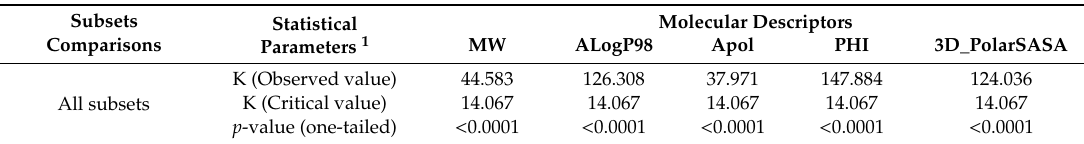
Table 3. Statistical parameters of the Kruskal–Wallis test on the distribution of the molecular descriptors for the odor subsets.